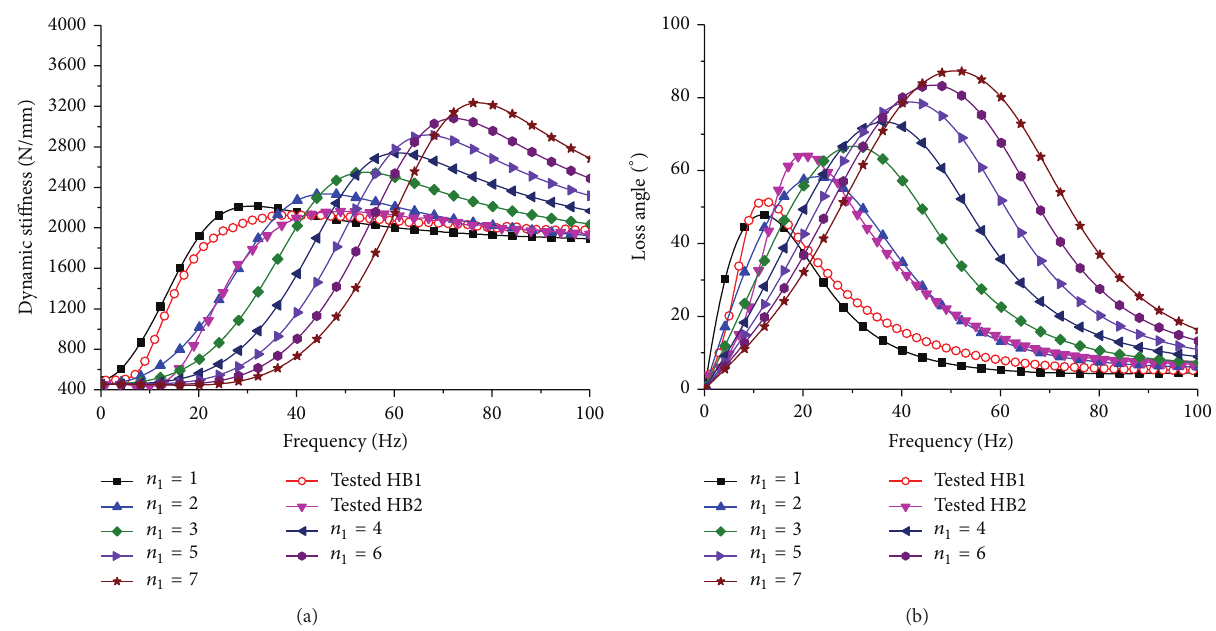
Figure 12: Calculated dynamic performances of HDB with inertia tracks increasing. (a) Dynamic stiffness. (b) Loss